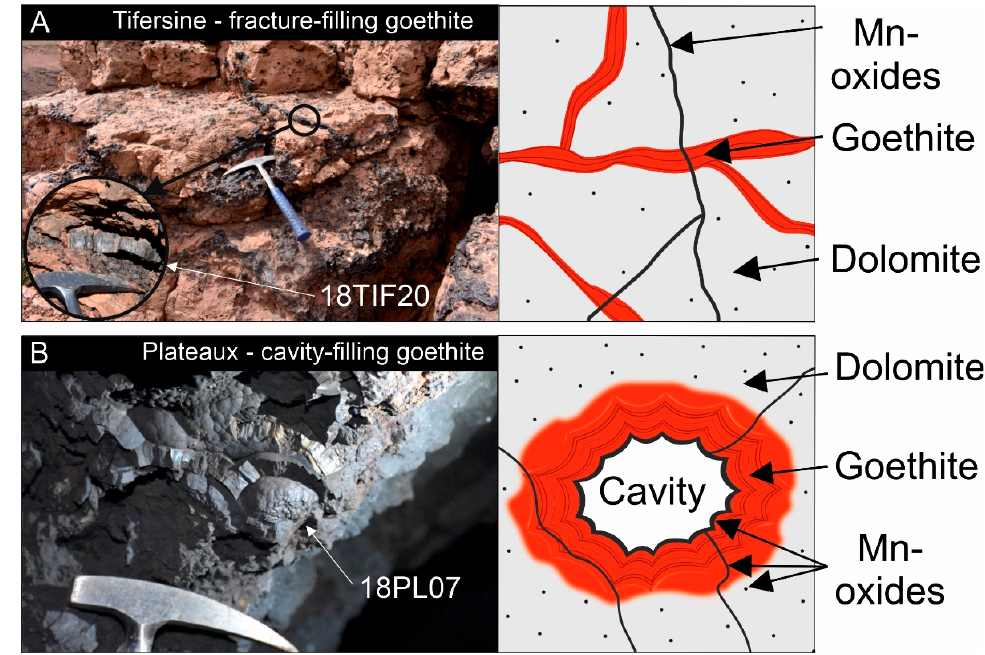
Figure 3. Style of the Fe mineralization and schematic representations. ( A ) Botryoidal goethite filling fractures and forming thin veins at Tifersine site (sample 18TIF20). ( B ) Large botryoidal goethite filling cavities at the Plateaux site (sample 18PL07).